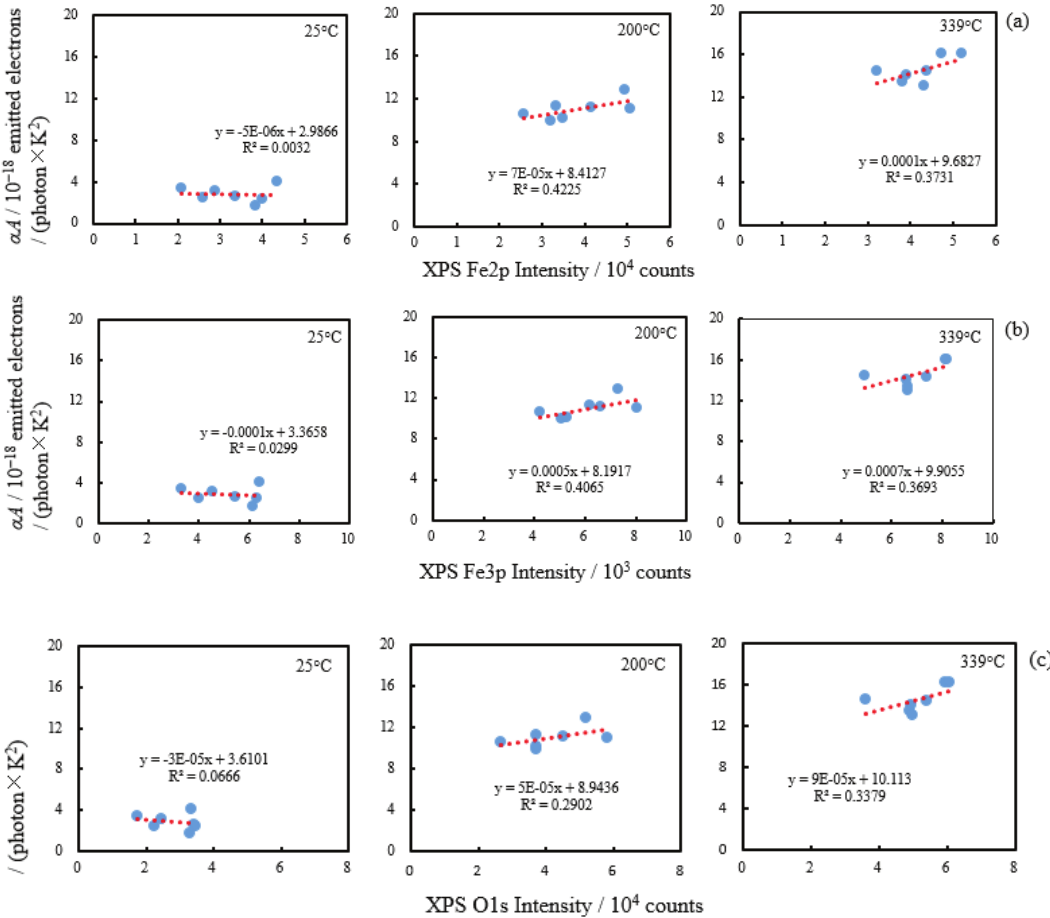
Figure 13. Dependence of the average electron photoemission probability, α A , on ( a ) XPS Fe 2 p intensity, ( b ) XPS Fe 3 p intensity, and ( c ) XPS O 1 s intensity at 25, 200, and 339 ◦ C for all environments.